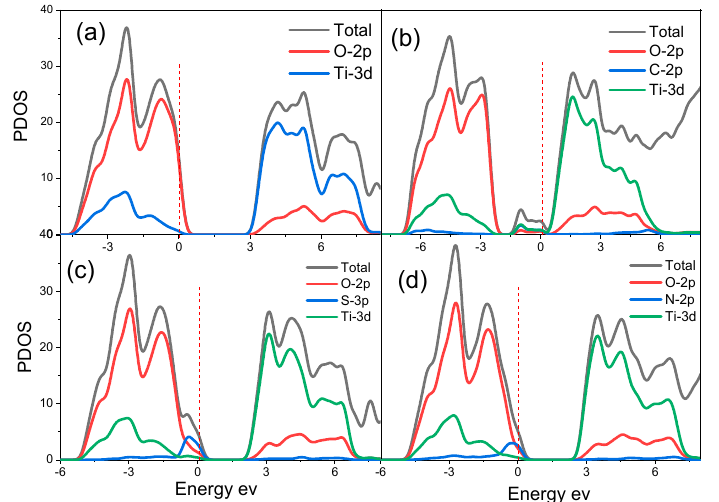
Figure 3. Calculated density of states (DOS) of ( a ) pure, ( b ) C-doped, ( c ) S-doped, and ( d ) N-doped bulk brookite TiO 2 .